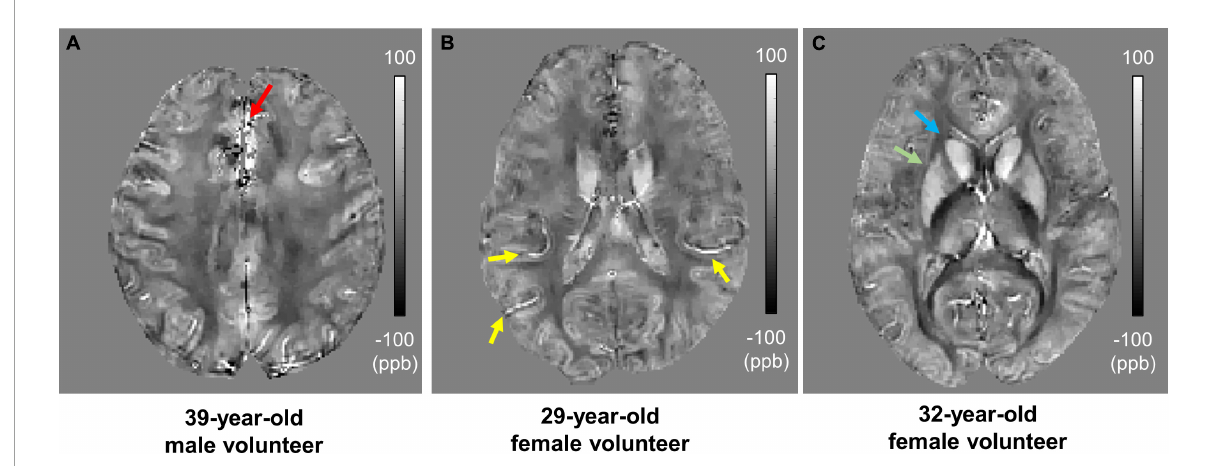
FIGURE5 In vivo ultrashort echo time quantitative susceptibility mapping (UTE-QSM) of three representative healthy volunteers. (A) 39-year-old male, (B) 29-year-old female, and (C) 32-year-old female. The estimated susceptibility maps show a clear contrast between different tissues including the white matter, gray matter, vessels (yellow arrows), caudate (blue arrow), and putamen (green arrow). Artifactually elevated susceptibility was observed in the region indicated by the red arrow which is presumably due to streaking artifacts or imperfection in UTE-QSM.